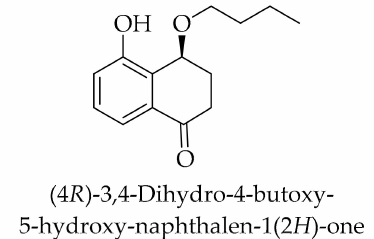
Figure 4. The chemical structure of new naphthalenone identified in the walnut green husk. 1,4,5-trihydroxynaphthalene-1,4-di- O - β -D-glucopyranoside, 1,4,5-trihydroxynaphthalene- 1,5-di- O - β -D-glucopyranoside, 1,4,8-trihydroxynaphthalene-1- O - β -D-[6 trihydroxybenzoyl)]glucopyranoside, 1,4,8-trihydroxynaphthalene-1- O - β -D-glucopyranoside, and 1,4,8-trihydroxy-3-naphthalenecarboxylic acid-1- O - β -D-glucopyranoside ethyl ester have been reported as naphthoquinone glycosides in the husk of J. mandshurica Maxim [144]. The chemical structures of the corresponding compounds are illustrated in Figure